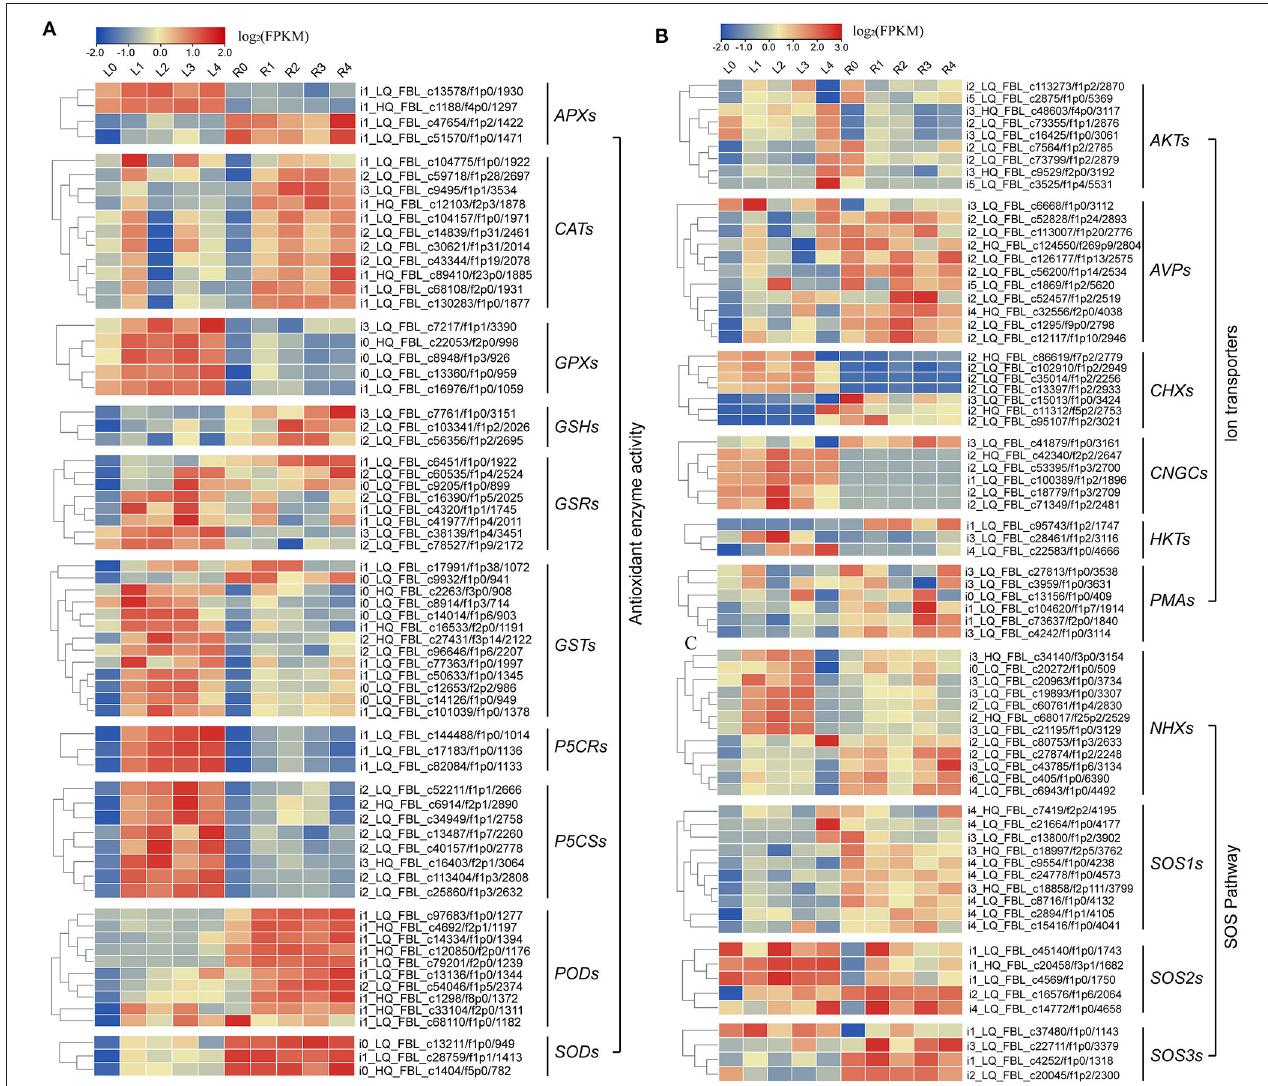
FIGURE 6 | Heat map plot of the expression levels of the DEGs involved in antioxidative, SOS, and ion transporter pathway under NaCl stress. (A) Heat map plot of the antioxidative defense-related DEGs by NaCl stress; (B,C) heat map plot of the DEGs of SOS pathway and ion transporters by NaCl